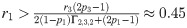
Selection for jumpwise de-differentiation when the effective rate of self renewal is highest in compartment 3.Illustration of the selection gradient ΔλJ as a function of the redistributing factor κ provided that λ0 = r3(p3 − q3). In both panels, colored lines represent eigenvalue perturbation results in Eq (9) and symbols represent exact numerical solutions. The common parameters are n = 4, ρ = 0.01, d = 0.05. (a) Expanding case (λ0 > 0). In this case, there are two different scenarios: For r1>r3(2p3-1)2(1-p1)Γ2,3,2+(2p1-1)≈0.45, ΔλJ is always positive (blue color). For r1 < 0.45, ΔλS is changed from positive to negative with the increase of κ (red color). Here p1 = 0.5, p2 = 0.65, p3 = 0.85, r2 = 0.4, r3 = 0.6. (b) Homeostasis case (λ0 = 0). In this case, ΔλJ is always positive. Here p1 = 0.01, p3 = 0.5, r1 = 0.8, r2 = 0.7, and r3 = 0.2.